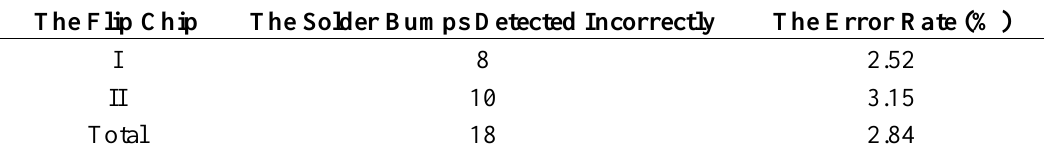
Table 1. The classified results of the solder bumps in the flip